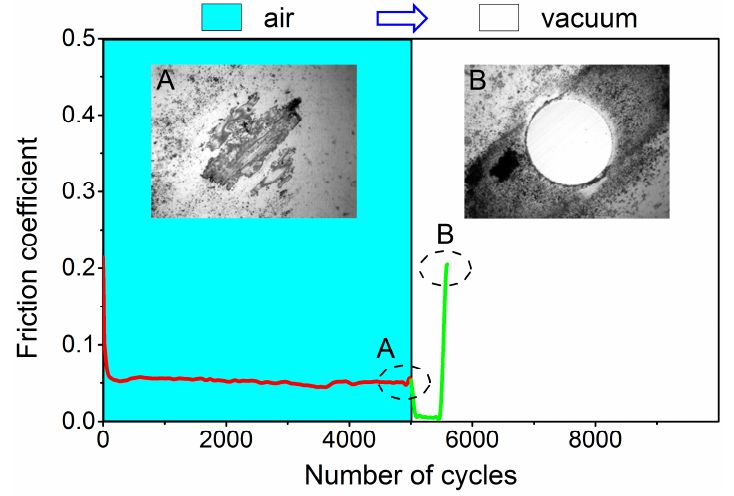
Figure 7. Friction behaviors of H-DLC film slid against Al 2 O 3 ball in humid air following sliding tests in vacuum (10 − 3 Pa) after ~5000 cycles. Upper insets compare topographical images of Al 2 O 3 ball after sliding tests in humid air ( A ) and vacuum ( B ). Sliding velocity and normal load were maintained at 200 mm / s and 10 N during entire experiment, respectively.